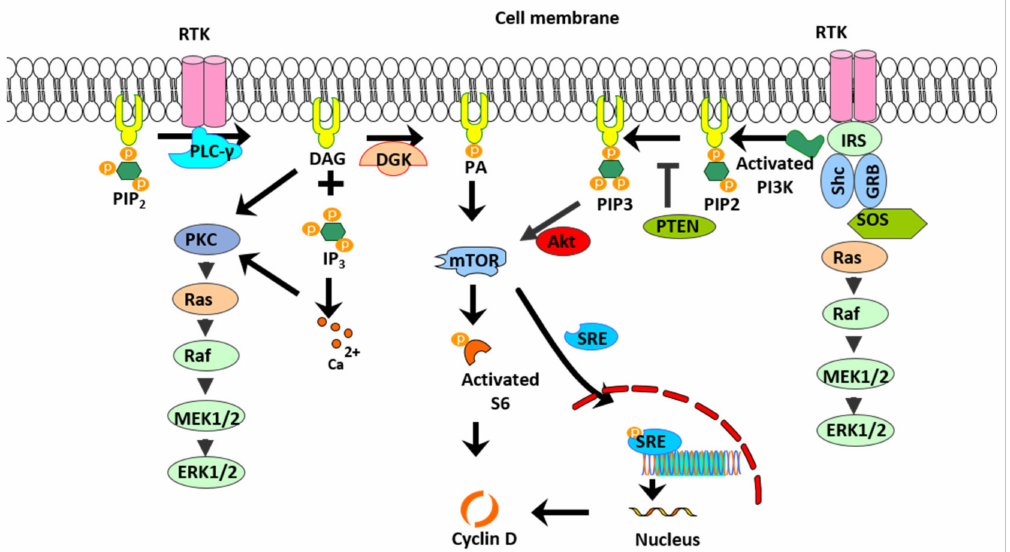
Figure 10. Model depicting PA-mediated ASM cell proliferation. PA generated by DGK leads to increased formation and activity of mTORC1. mTOR increases activity of S6K and transcription factor SRE, resulting in increased transcription and translation of cell cycle progression genes, including cyclin D1. DGK inhibition attenuates mTOR signaling by depleting levels of PA in ASM cells. DAG produced upon activation of Gq-coupled GPCR and RTK signaling activates PKC and MAPK signaling pathways [17,36]. DAG is converted to PA by the action of a lipid kinase, DGK, and the functional role of PA in ASM cells has not been thoroughly investigated. PA is a phospholipid second messenger that is known to regulate a variety of cellular functions, including cell proliferation, migration, and differentiation